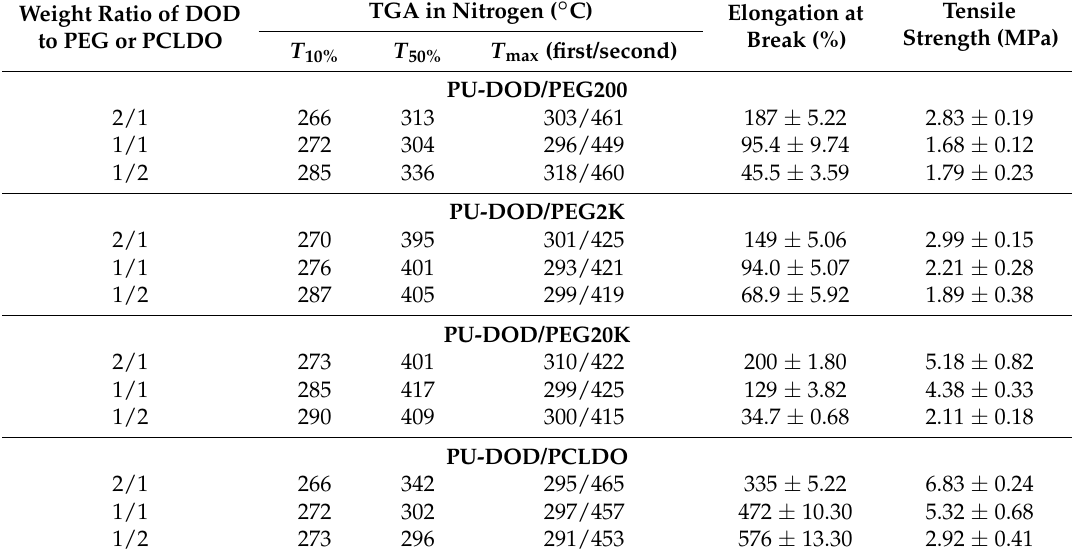
Table 2. Thermal and mechanical properties of PUs from DOD with PEG or PCLDO. Weight Ratio of DOD to PEG or